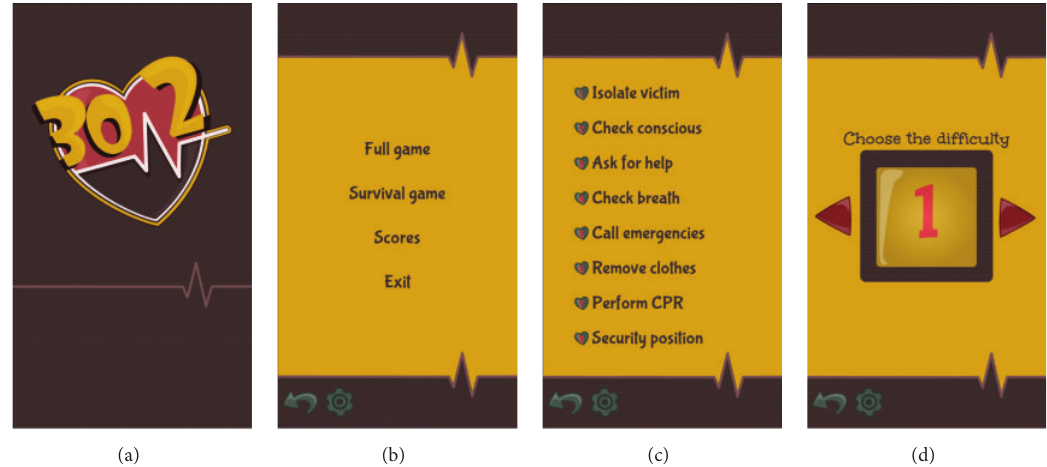
Figure 3: Game screens corresponding to (a) the main page and the menus to select (b) the playing mode, (c) the mini game, and (d) the difficulty